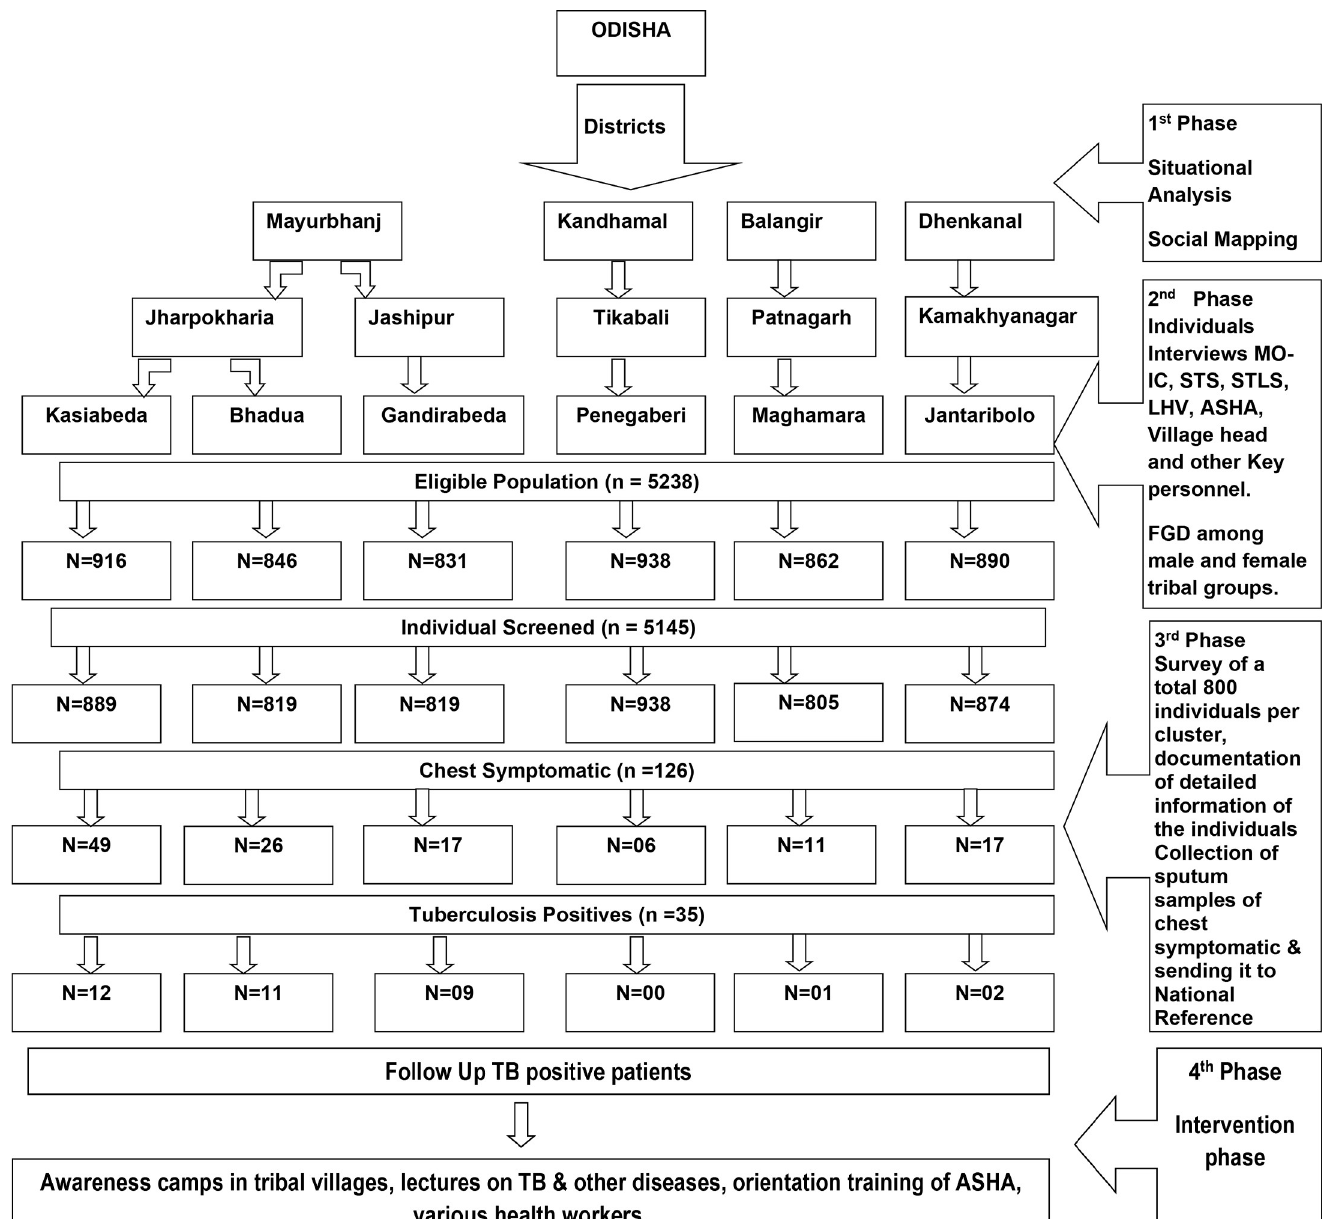
Fig 1. The schematic presentation of the study carried out in phases.